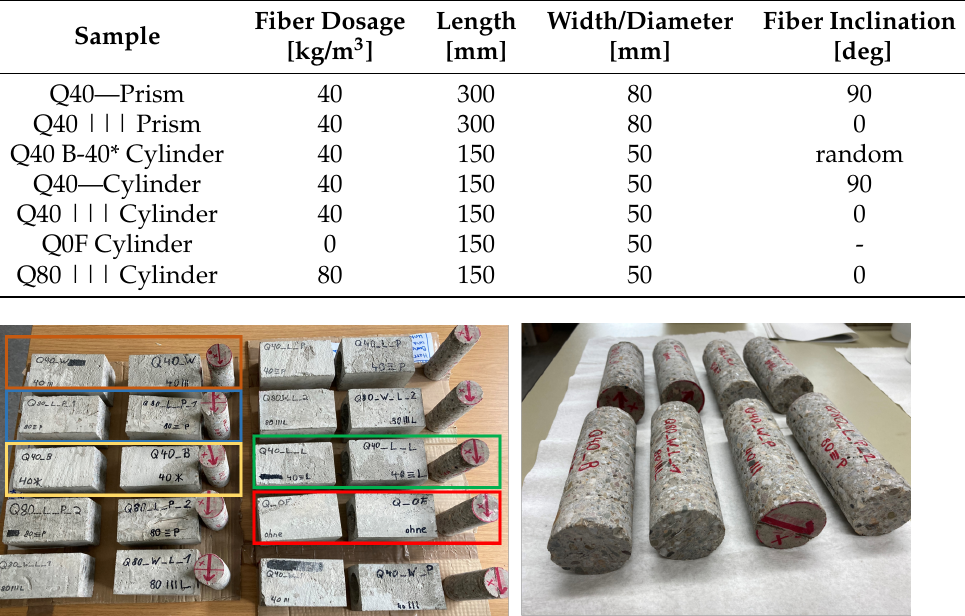
Figure 3. Photograph of the cast prismatic specimens (following being cut halfway along their length) and the extracted cylindrical sub-samples ( left ). The samples discussed in further detail are color-coded. Close-up on a selection of cylindrical sub-samples ( right ).